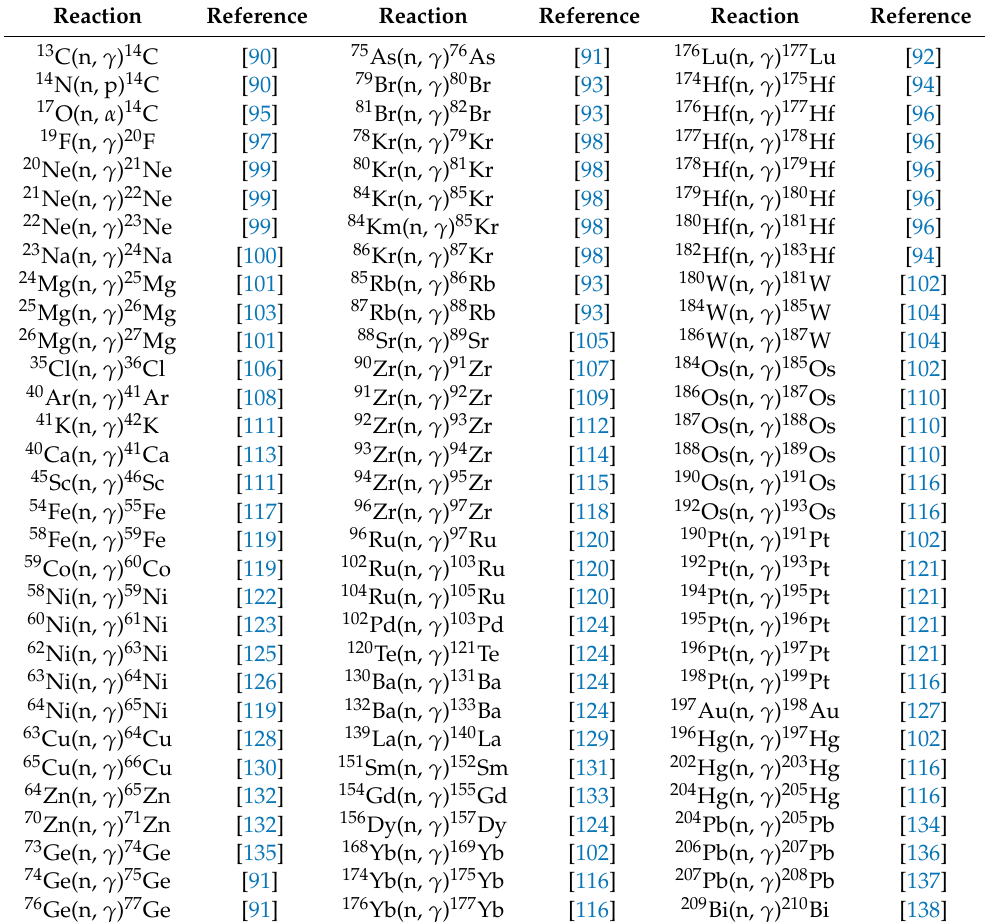
Table 2. Updated neutron-capture reactions included in the FUNS’s nuclear